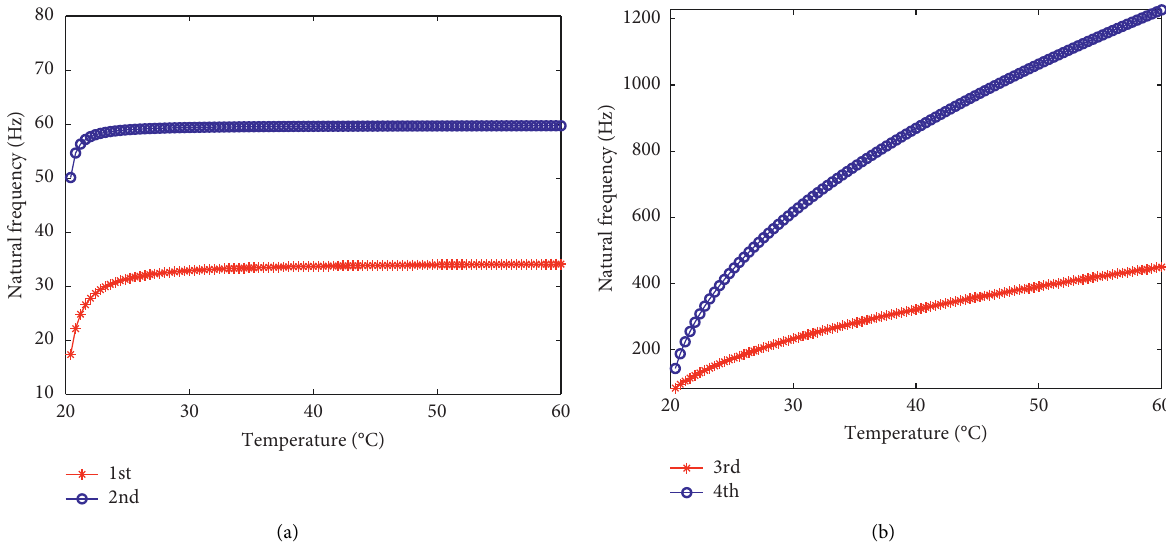
Figure 4: The (a) 1st, 2nd and (b) 3rd, 4th change curves of natural frequencies under different environmental temperatures.